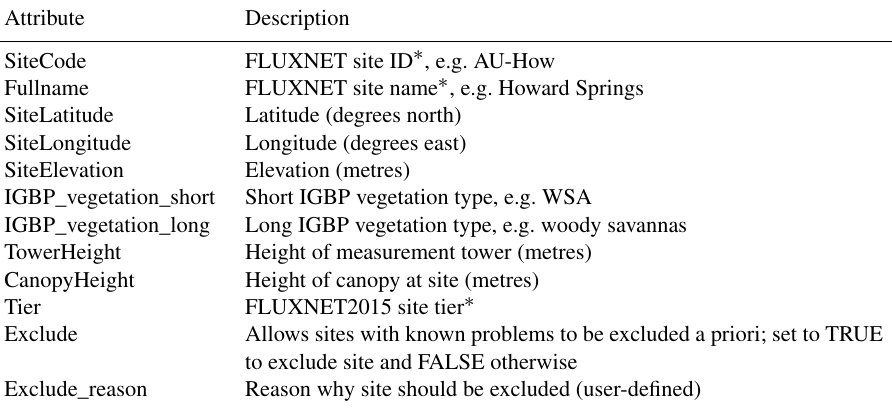
Table 2. Site metadata provided with the package. All attributes are provided for each Tier 1 site, with the exception of tower and canopy